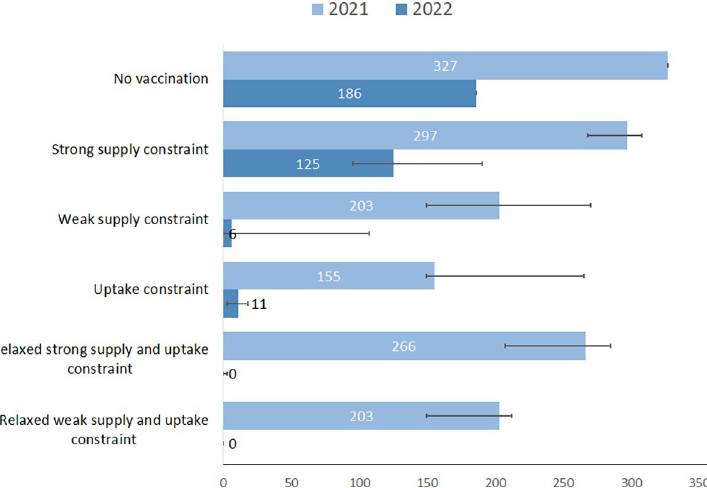
Fig 2. Number of NPI activation periods in 2021–2022 and peak hospitalization incidence in the absence of NPIs. Based on reference scenario for disease characteristics, NPI response (second wave threshold), and vaccine profile (protection against infection). The number of days and error bars corresponds respectively to reference, minimum and maximum values for an efficacy of 70% ranging from 50% to 90%.